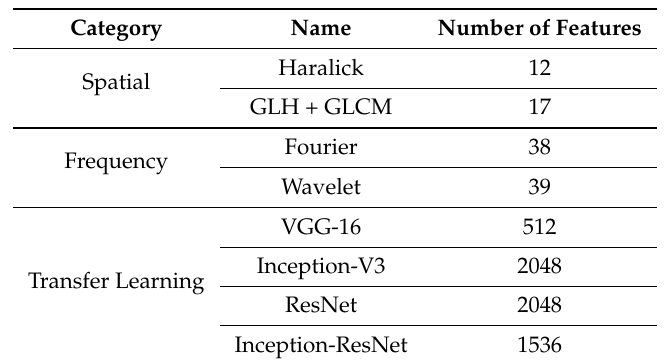
Table 1. The list of all of the feature extraction methods performed in this paper and their associated extracted number of